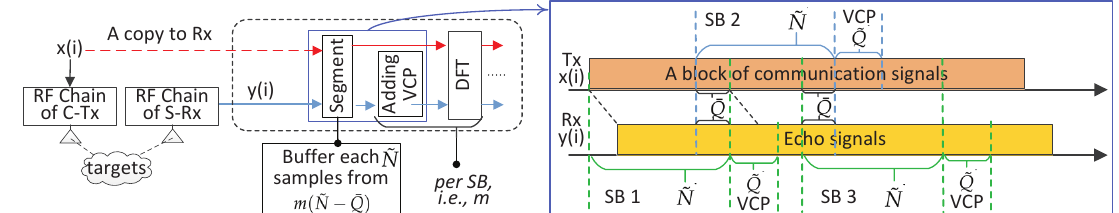
Figure 5. A novel sensing framework that suits OFDM, DFT-s-OFDM and OTFS, where SB stands for sub-block and VCP for virtual CP. The left sub-figure shows the sensing diagram, where the DFT results will go through the last three steps in Figure 3 to generate RDMs. The right sub-figure is a novel signal segmentation proposed in [39], where x ( i ) can be the middle signal in Figures 1 or 2. That is, the sensing framework suits OFDM or DFT-s-OFDM with regular CPs (one per symbol), as well as the OTFS with a reduced CP (i.e., a single CP for a long block of symbols). The DFT results in Figure 5 can be input to PWD and PWP for generating